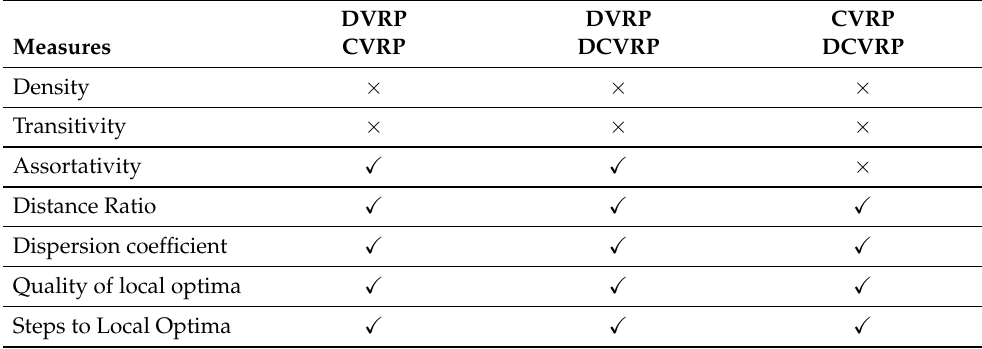
Table 3. Results for Repeated Measures ANOVA for LONA measures—Multi-Attribute Perspective.